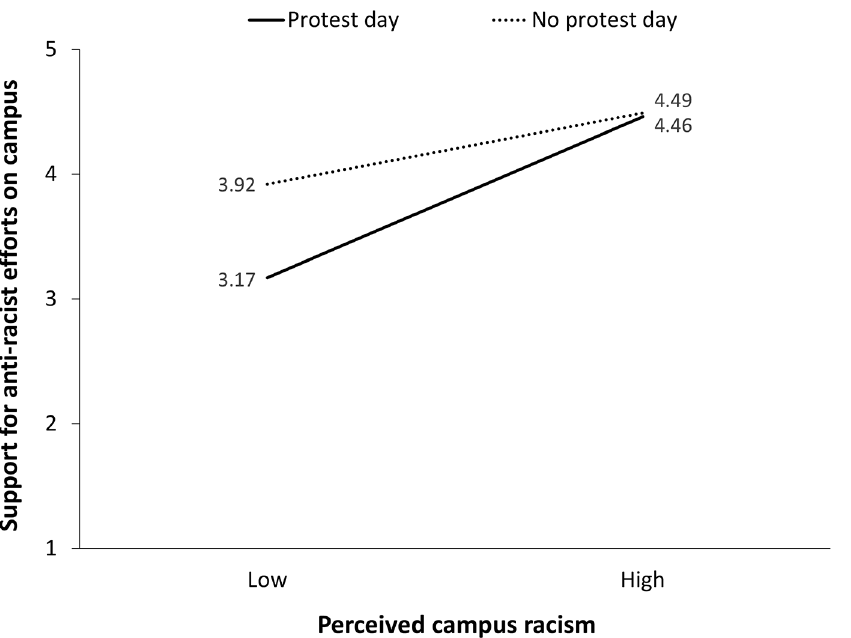
Figure 1. Support for anti-racist efforts on campus as a function of the interaction between perceived campus racism and condition (protest vs. no-protest